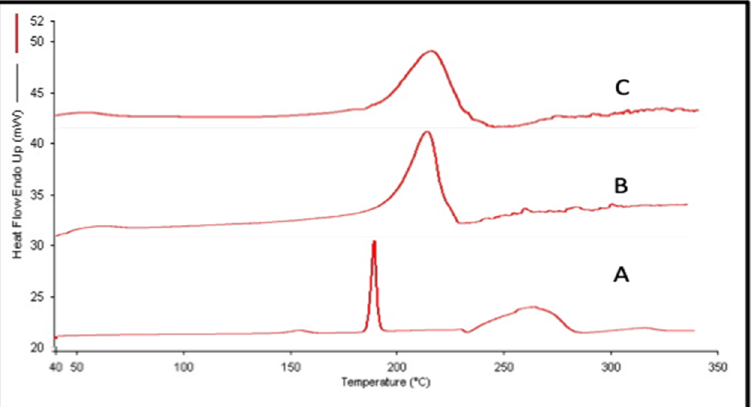
Figure 3. Overlay of DSC thermograms of (A) CBZ, (B) FA, and (C) CBZ-FA complex.